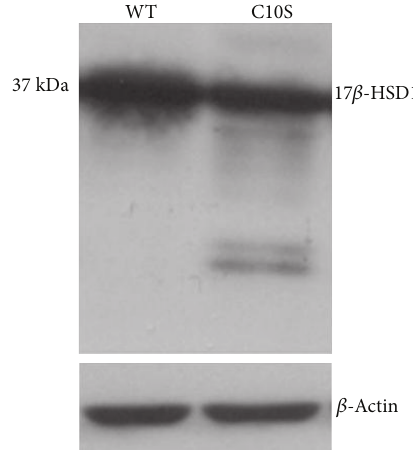
Figure 4: Western blot analysis of the protein expression of histidine-tagged wild-type 17 𝛽 -HSD1 and mutant Cys 10 Ser. A repre- sentative experiment from four independent transfections is shown.